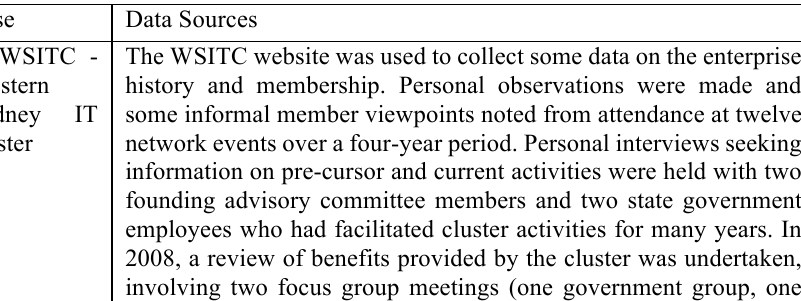
Table 3. Case study data collection